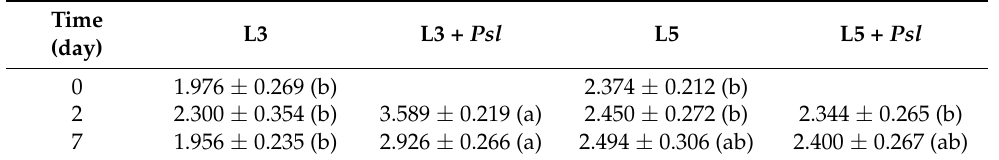
Table 1. Respiration intensity ( μ mol O 2 m –2 s –1 ) in cucumber leaves after Pseudomonas syringae pv lachrymans infection.